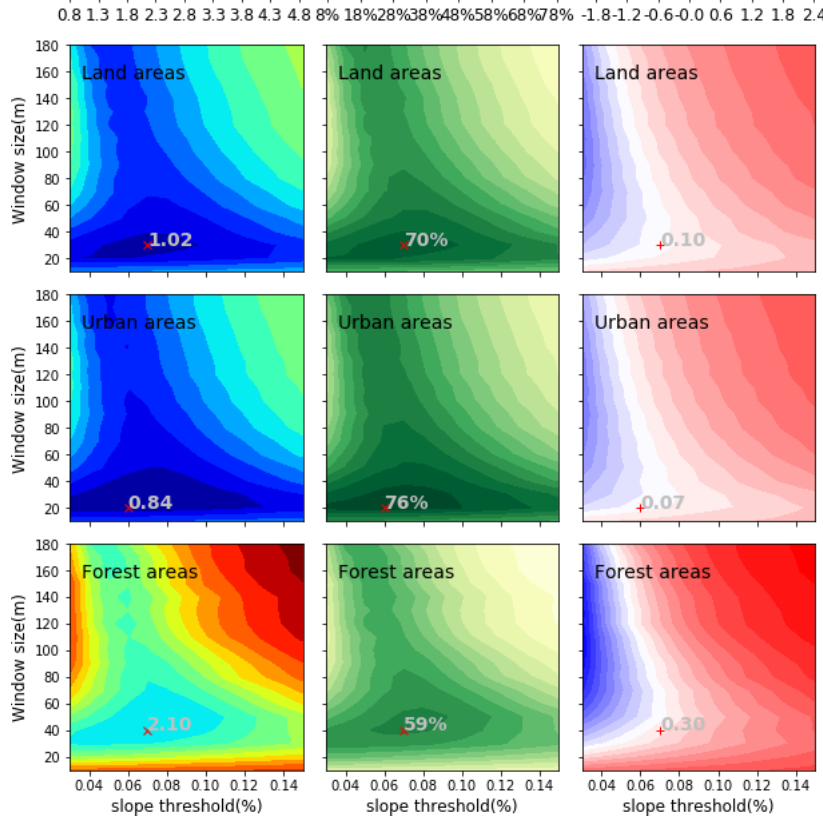
Figure 4. Surface plots of the slope threshold and the window size parameters of the SMRF filter against the RMSE, the RMSE reduction percentage, and mean error in the filtered ArcticDEM-SMRF for sample S3. The locations of the smallest values of the RMSE (which is the same as the location of the greatest values of the RMSE reduction) are marked as × , with the values displayed. The values of the mean error at the above location are displayed and marked as + . Parameter details can be found in Table